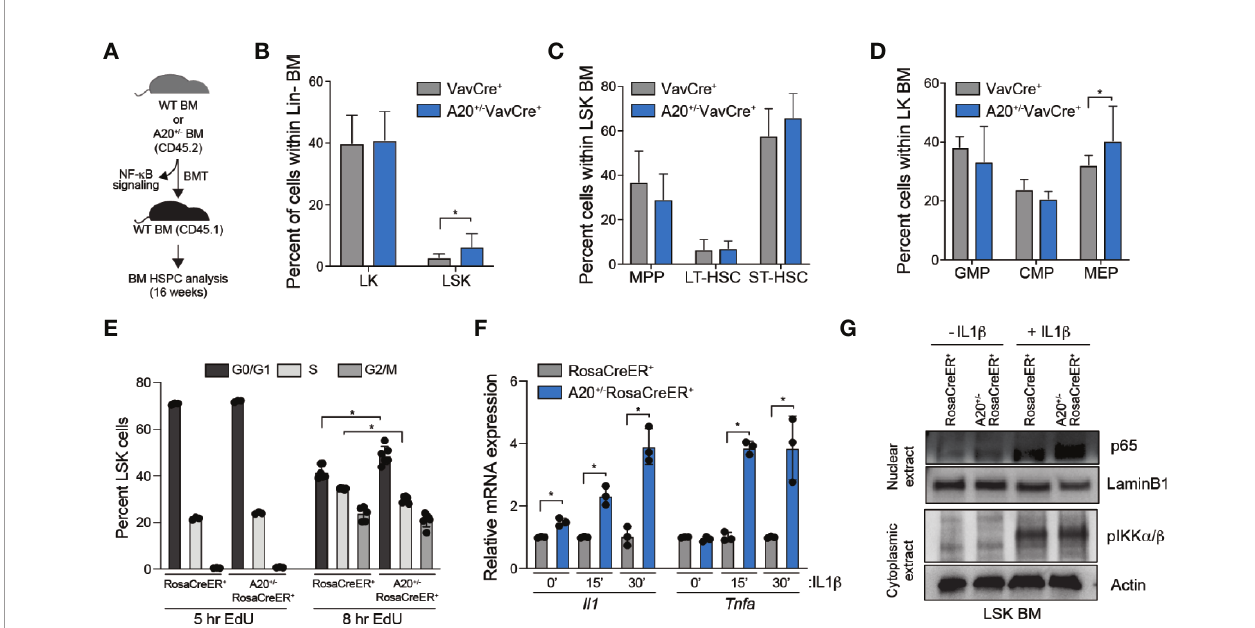
FIGURE 3 | Heterozygous deletion of A20 affects hematopoietic stem and progenitor cell frequency. (A) Outline of experiments utilizing WT (VavCre + or RosaCreER + ) and A20 +/- (A20 +/- VavCre + or A20 +/- RosaCreER + ) mice for NF- k B signaling and HSPC analysis. (B – D) Summary of BM HSPC proportions at 16 weeks after transplantation using VavCre + (n = 6) or A20 +/- VavCre + BM cells (n = 8). (E) Flow cytometric analysis of RosaCreER + and A20 +/- RosaCreER + LSK BM treated with 10 m M EdU for 5 h (LSK pooled from three mice per group) or 8 h (LSK from three individual mice per group) followed by staining with anti-EdU and DAPI. (F) Il1 and Tnfa mRNA expression by qRT-PCR in RosaCreER + and A20 +/- RosaCreER + LSK with 10 m M IL-1 b stimulation for the indicated lengths of time (n = 3 mice per group). (G) Expression of nuclear p65 and cytoplasmic pIKK a / b by immunoblot in RosaCreER + and A20 +/- RosaCreER + LSK BM cells with and without 15 min 10 m M IL-1 b treatment. *P < 0.05. Data are represented as mean ±